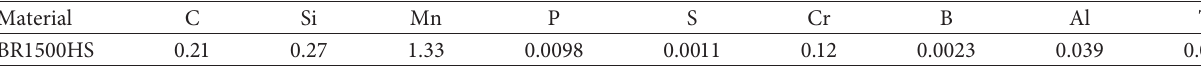
Table 1: Composition of BR1500HS.